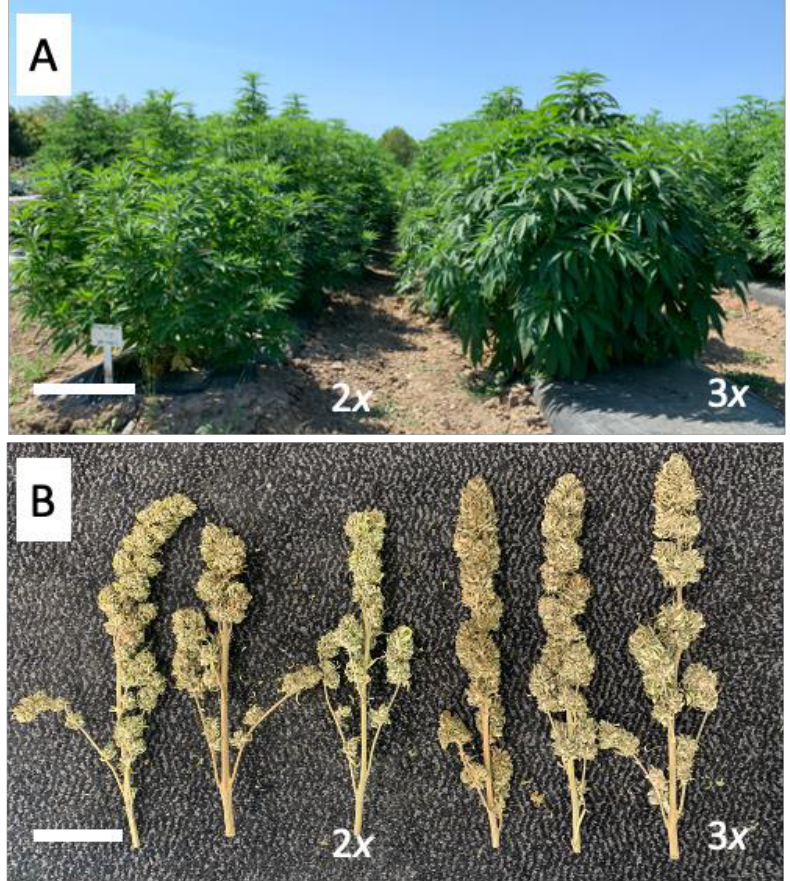
Figure 4. Whole-plant and inflorescence architectures of diploid and triploid hybrid C. sativa plants in the field. ( A ) Plants 60 days following transplant growing in the field. Diploid plants are on the left and triploid plants are on the right. Bar = 30 cm. ( B ) Dried terminal inflorescences of three diploid (left) and three triploid C. sativa plants (right). Bar = 10 cm.